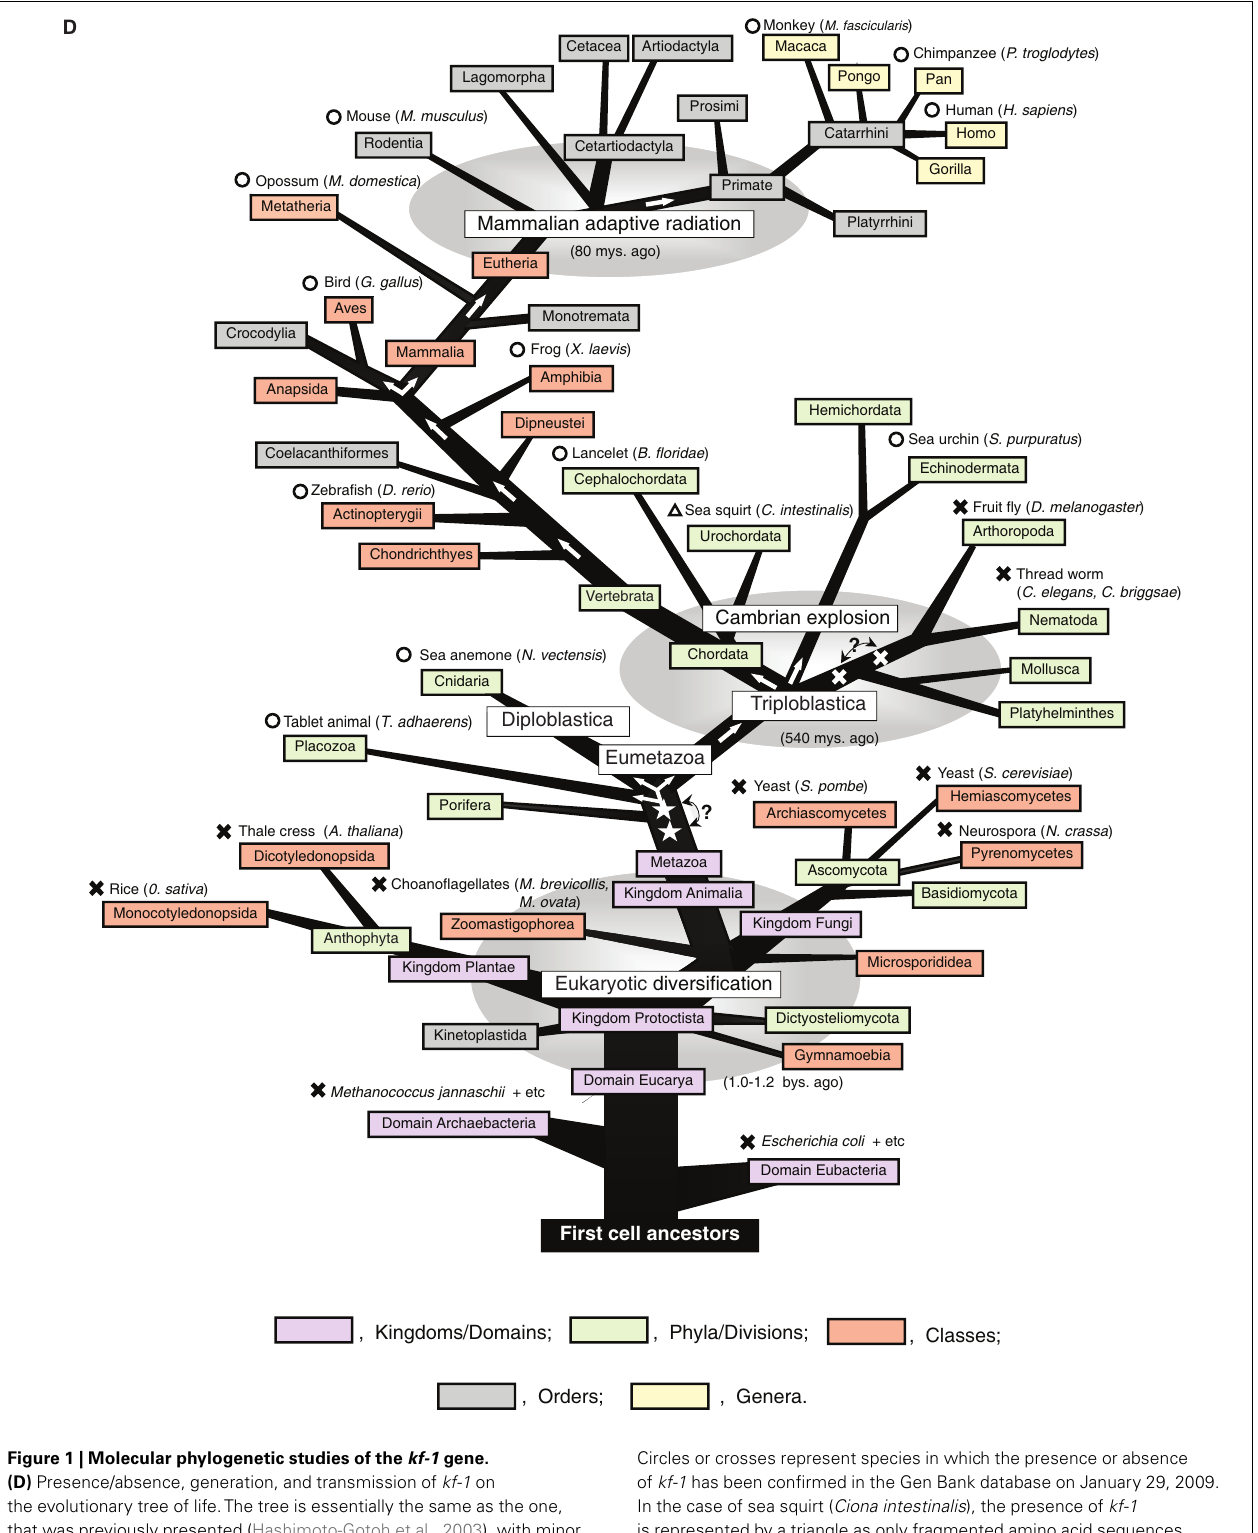
Figure 1 | Molecular phylogenetic studies of the kf-1 gene. (D) Presence/absence, generation, and transmission of kf-1 on the evolutionary tree of life. The tree is essentially the same as the one, that was previously presented (Hashimoto-Gotoh et al., 2003), with minor modifi cations and corrections except for the genes concerned. ‘?’ with bi-arrows and two open stars or crosses denotes uncertainty of the precise position of generation or loss of kf-1 ,